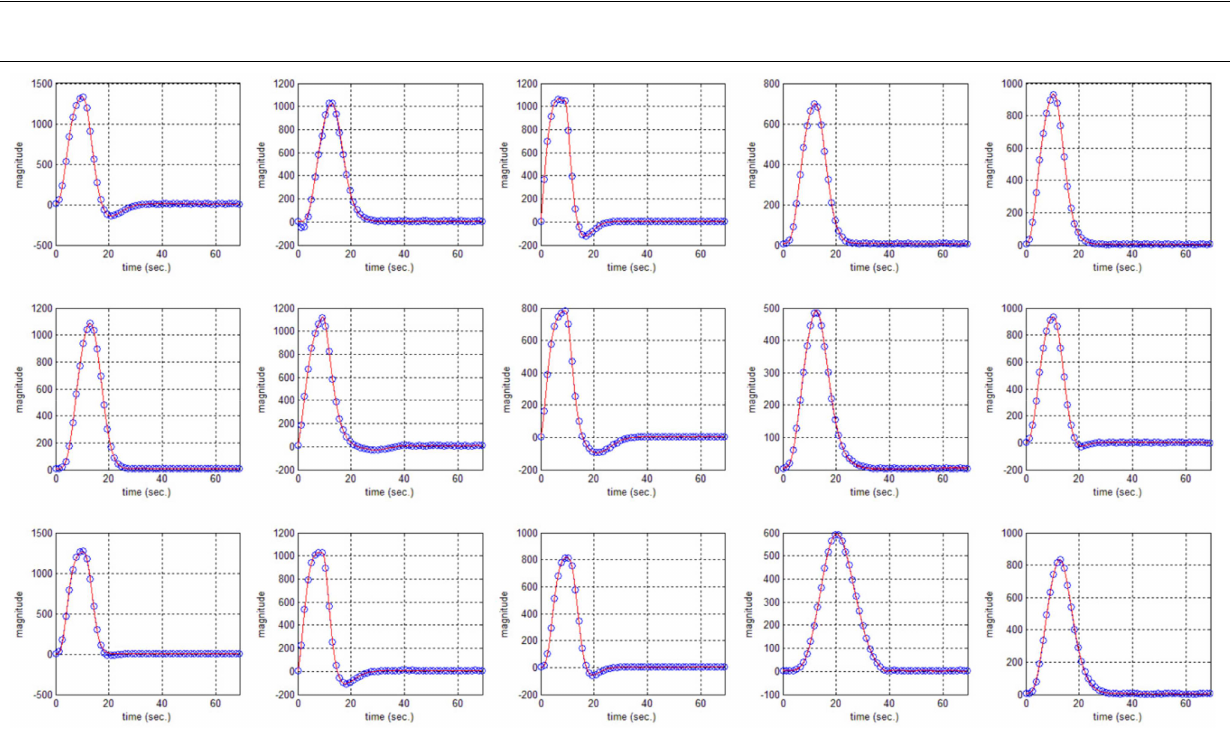
Frontiers in Behavioral Neuroscience |